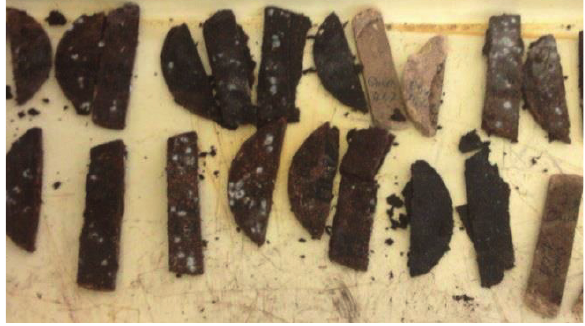
Figure 3 Plant plastic from millet husk, plant plastic from wheat husk, and wood plastic kept in active soil for 21 days (all plastics are made without adhesives)